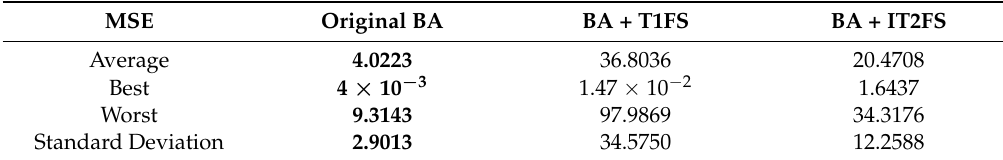
Table 12. Comparison of results of the original BA, the BA + T1FS and BA + IT2FS.